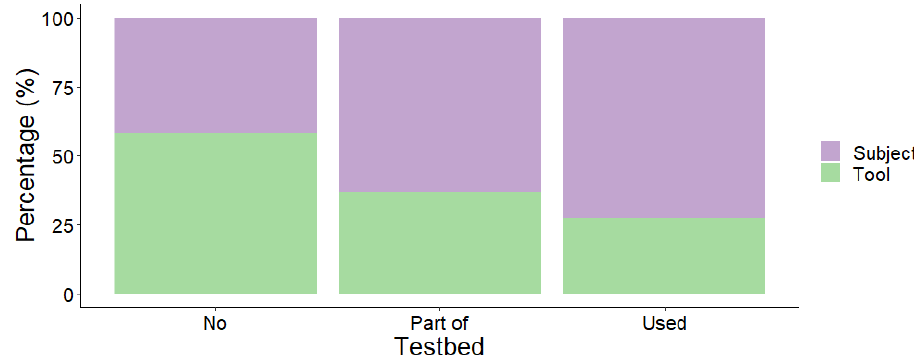
Figure 31. Deployment distribution between usage of testbed facilities and deployment type.